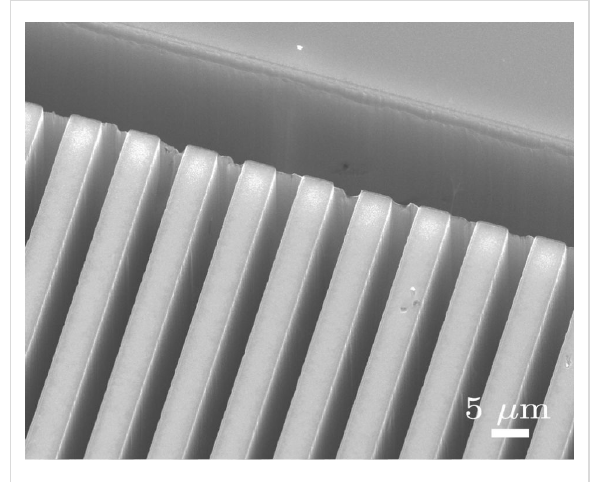
Figure 13: SEM image showing a top view of very deep trenches in silicon, obtained by MaCE. Patterned gold stripes have been used as catalyst.